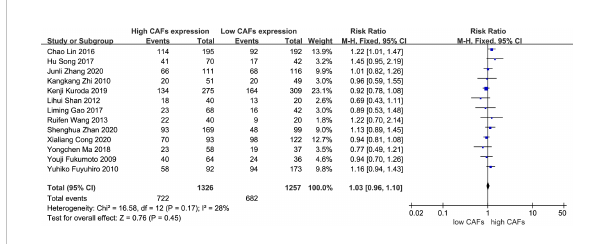
FIGURE 7 Correlation between CAFs and differentiation in gastric cancer. CAF, cancer-associated fi broblast; CI, con fi dence interval.